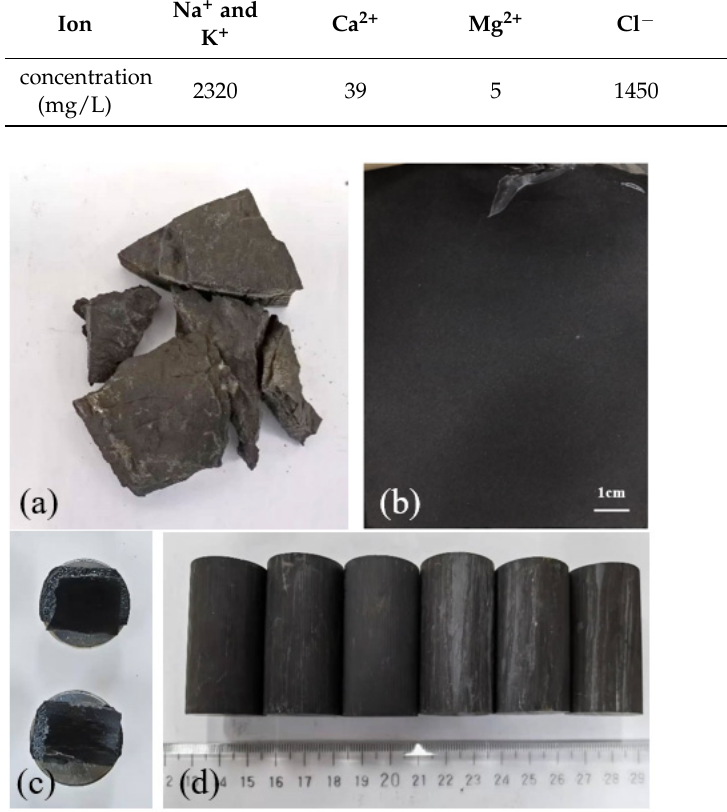
Figure 2. Photos of the processed samples: ( a ) crushed samples; ( b ) bulk samples; ( c ) SEM samples and ( d ) core samples . and ( d ) core